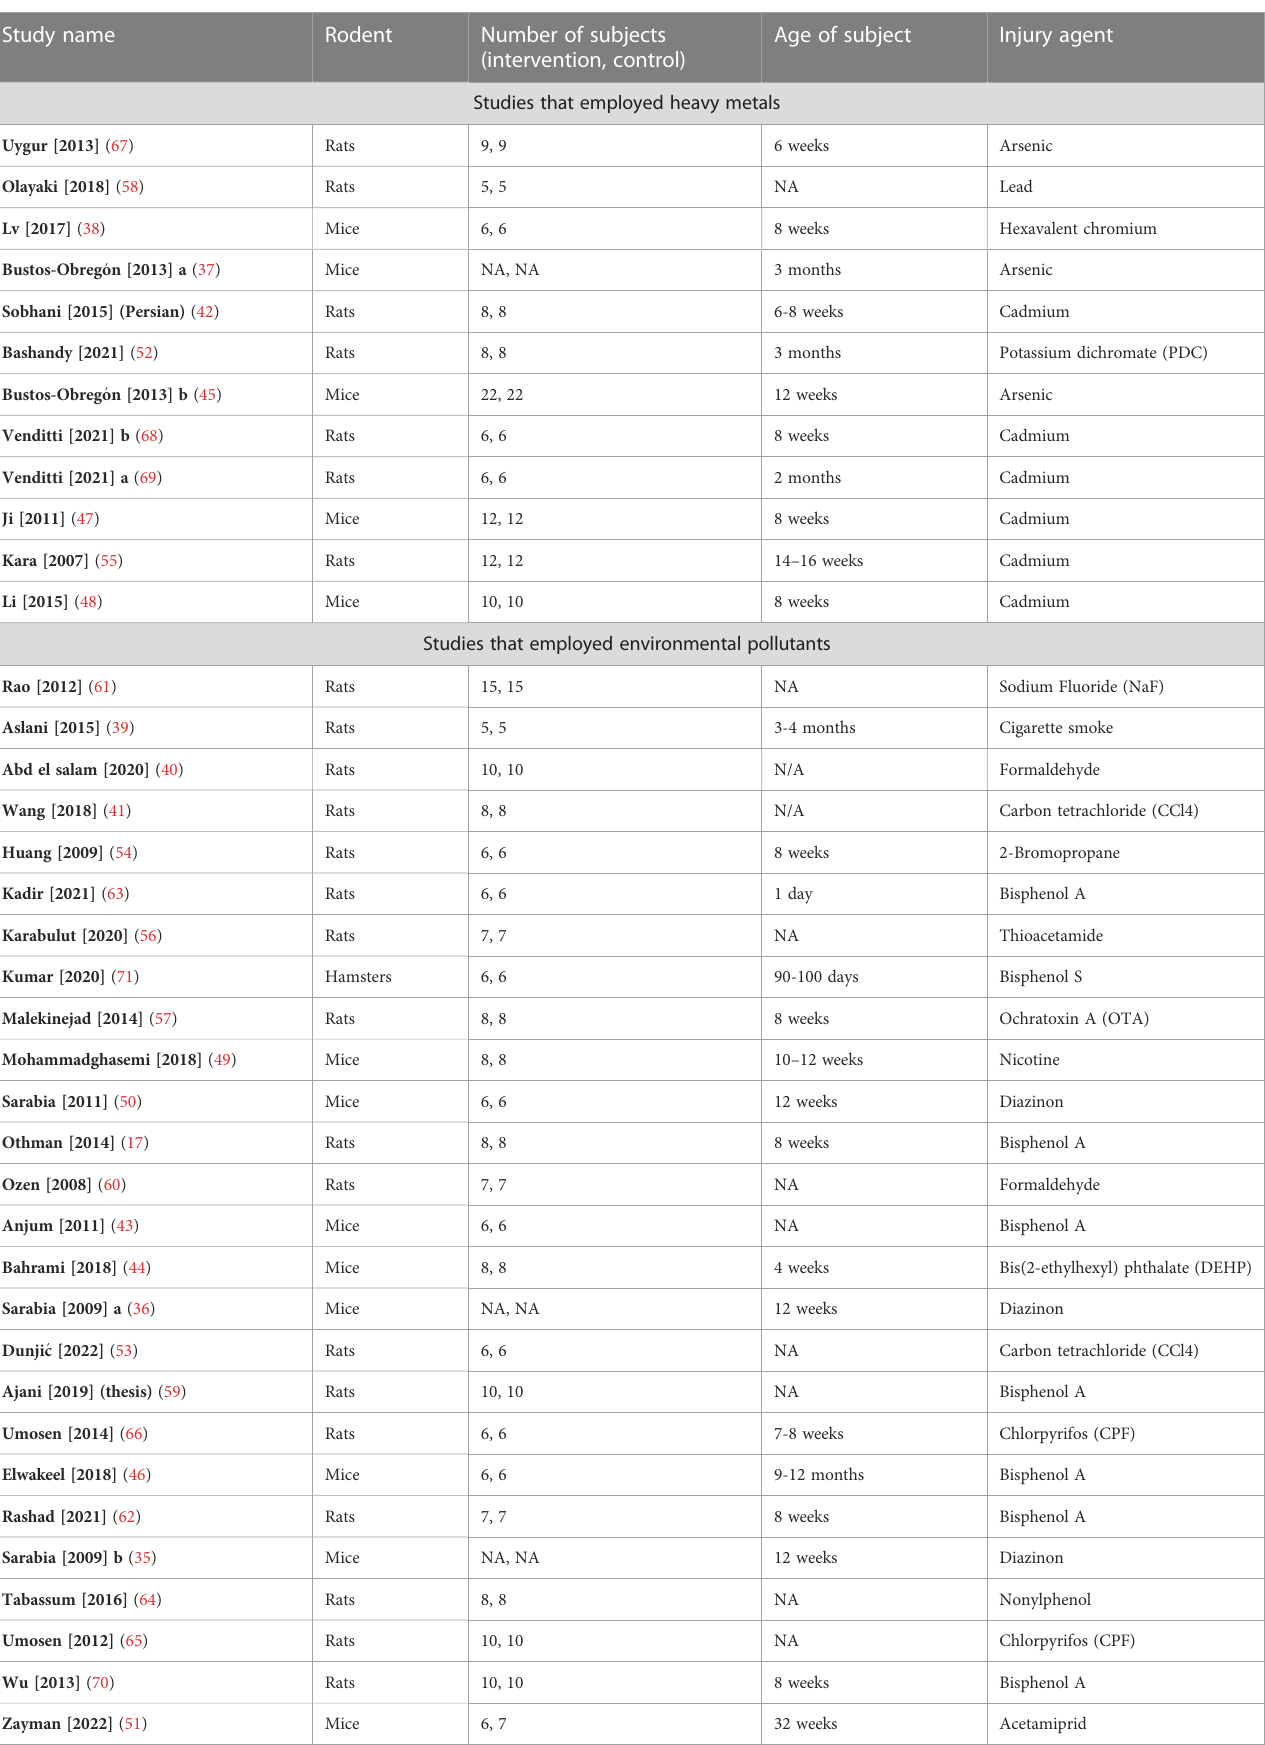
TABLE 1 General characteristics of the included